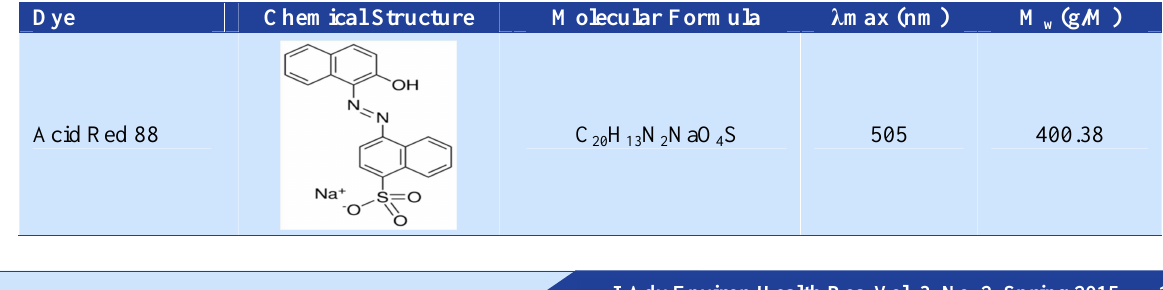
Table 1. Characteristics of Acid Red 88